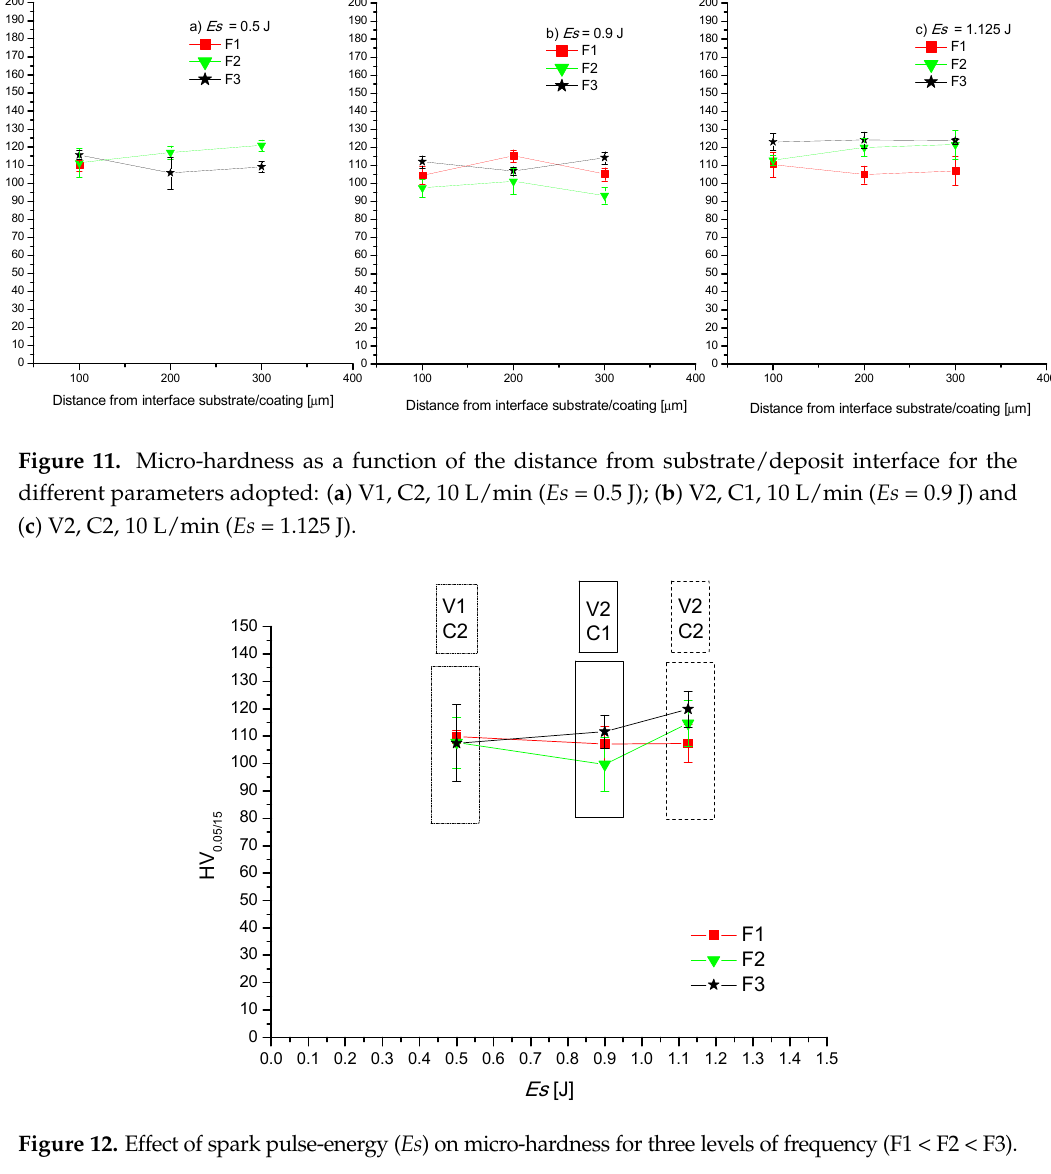
Figure 12. Effect of spark pulse-energy ( Es ) on micro-hardness for three levels of frequency (F1 < F2 < F3).